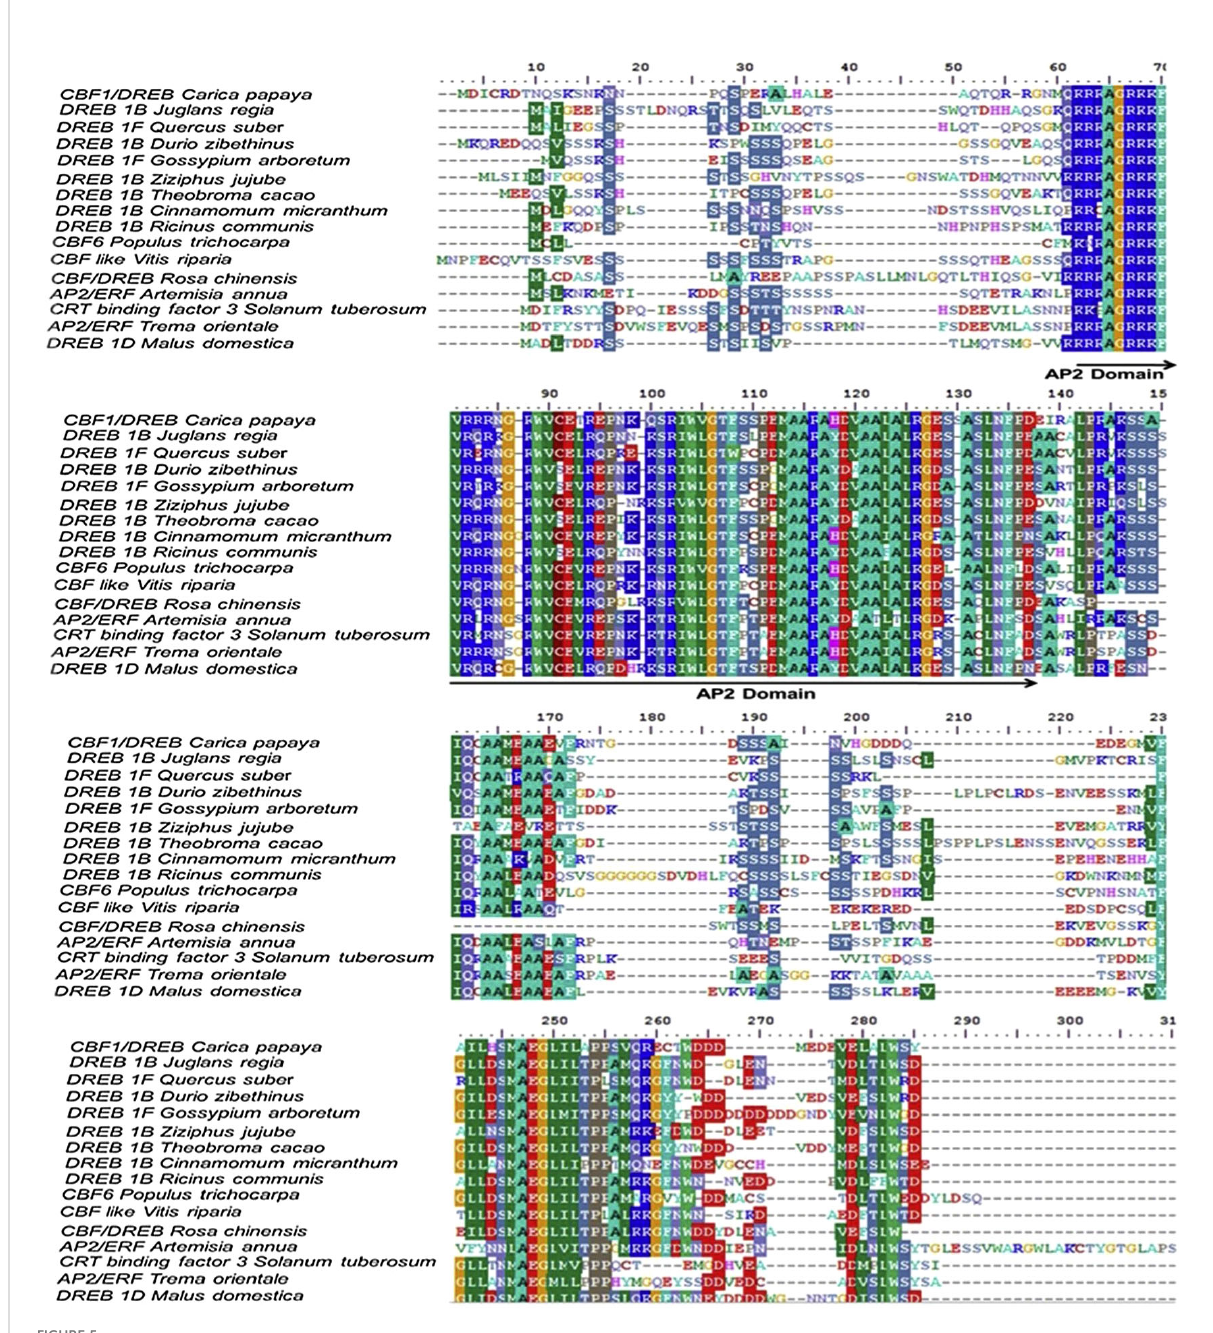
FIGURE 5 Alignment of the predicted amino acid sequences of the Carica papaya CBF1 / DREB from with another plant CBFs / DERB . All the designated sequences showed conserved domain of AP2, the characteristics of c-repeat binding factors. (FIGURE adapted from Maurya et al.,